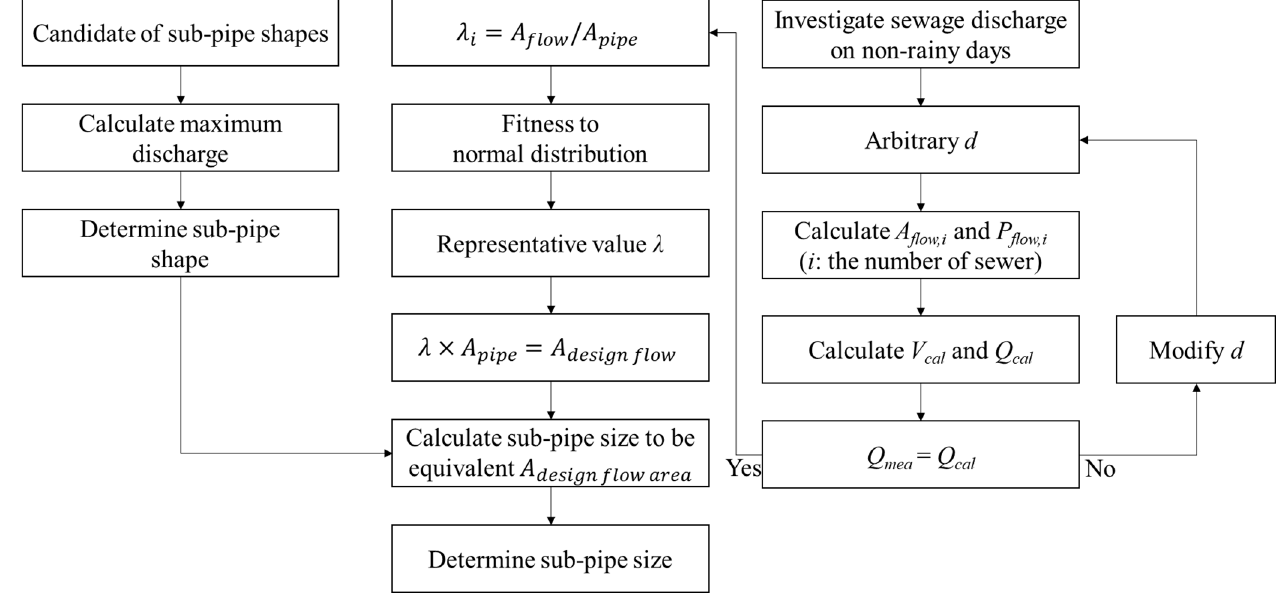
Figure 2. Flow chart to determine sub-pipe size.